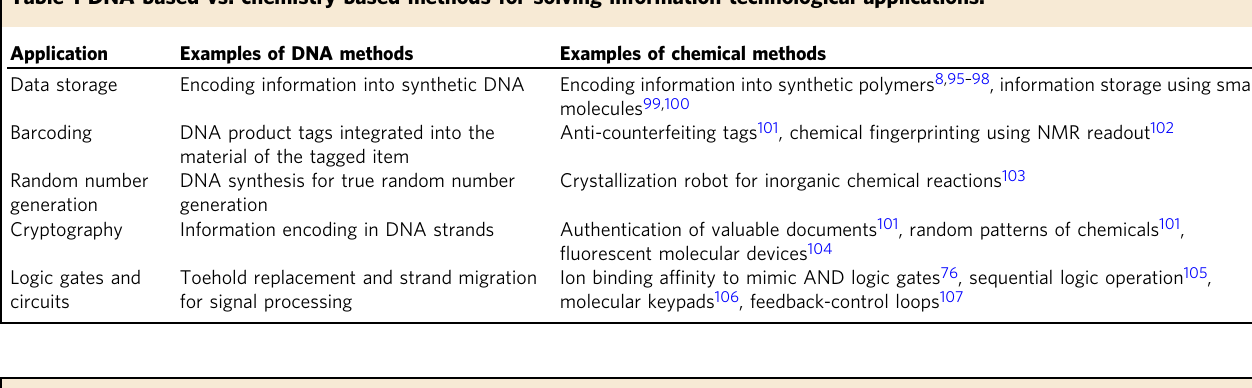
Table 1 DNA-based vs. chemistry-based methods for solving information technological